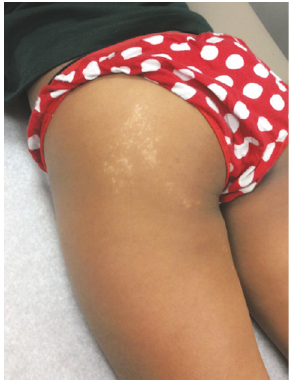
Figure 3: Hypopigmented macules and patch following the lines of Blaschko.